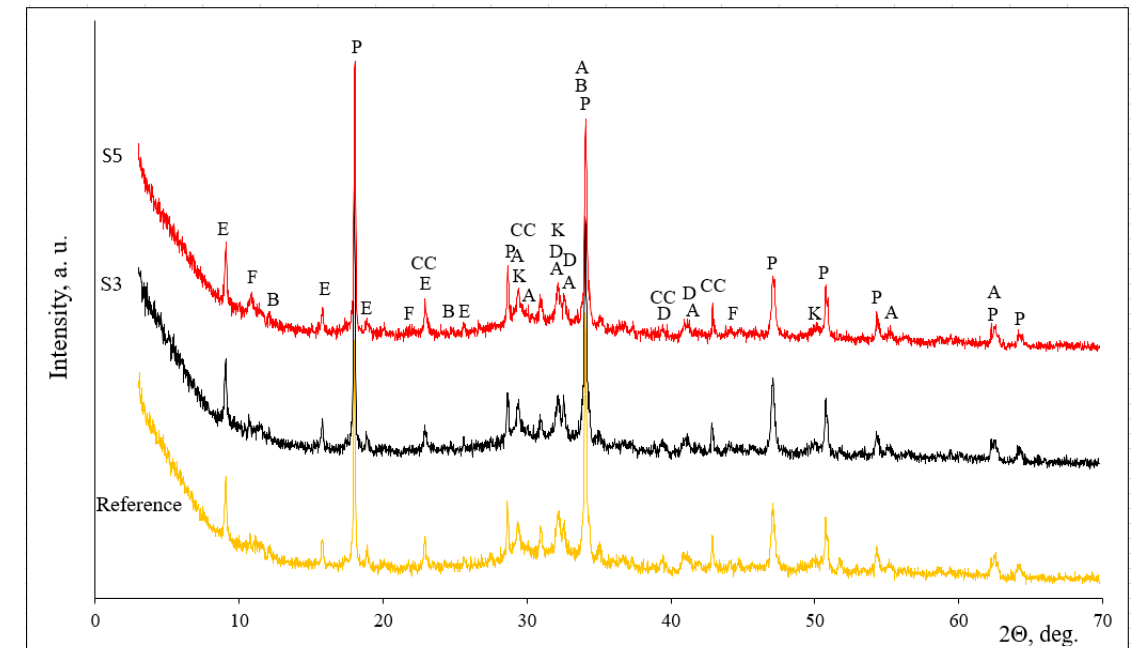
Figure 5. X-ray diffraction patterns of hardened cement paste samples containing the zeolitic by-product after 28 days of hydration: E—ettringite Ca 6 A l2 (SO 4 ) 3 (OH) 12 ∙ 26H 2 O (41-1451), P—portlandite Ca(OH) 2 (44-1481), A—Ca 54 MgA l2 Si 16 O 90 (13-272), D—larnite Ca 2 (SiO 4 ) (83-461), K—calcium silicate hydrate Ca 1 . 5 Si O 3 . 5 ∙ x H 2 O (33-306), CC—calcite CaCO 3 (72-1651),